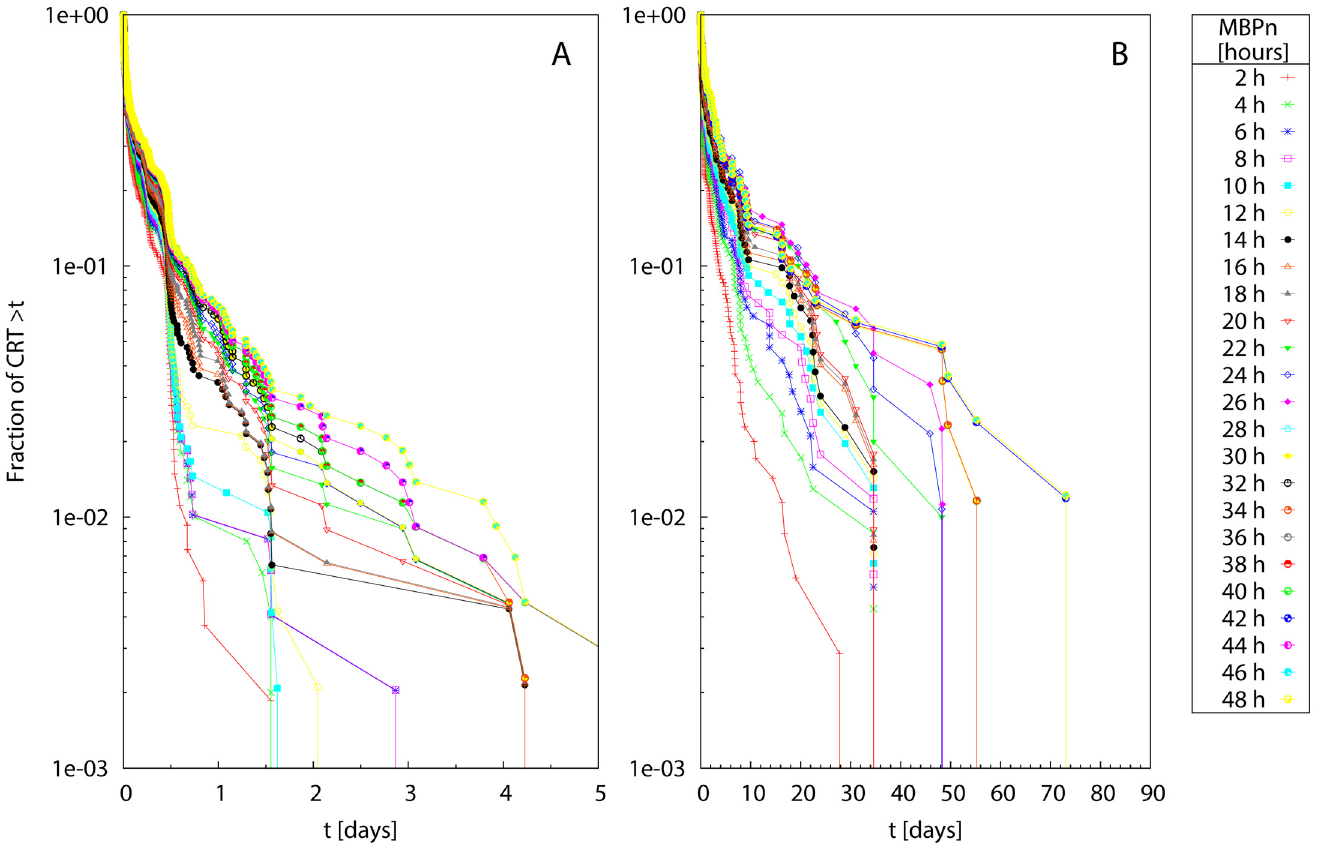
Fig 8. Field data: Survival curves of CRTs at large timescales. Survival curves calculated for MBP n ranging between 2 h and 48 h (see caption) for (A) Bigeye scad (B) yellowfin tuna.